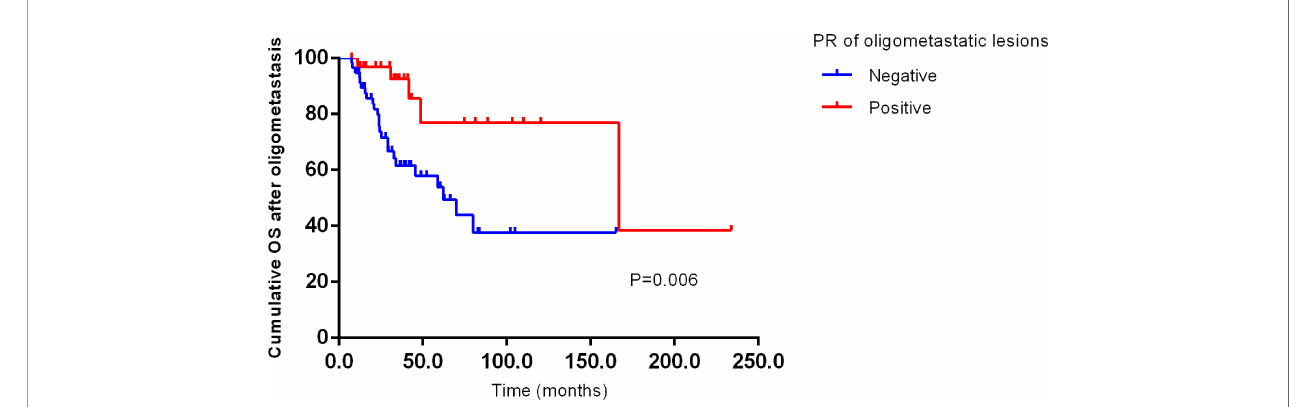
FIGURE 2 | Kaplan – Meier curve for OS of oligometastatic breast cancer patients strati fi ed by PR of oligometastatic lesions. PFS, progression free survival after oligometastasis; OS, overall survival